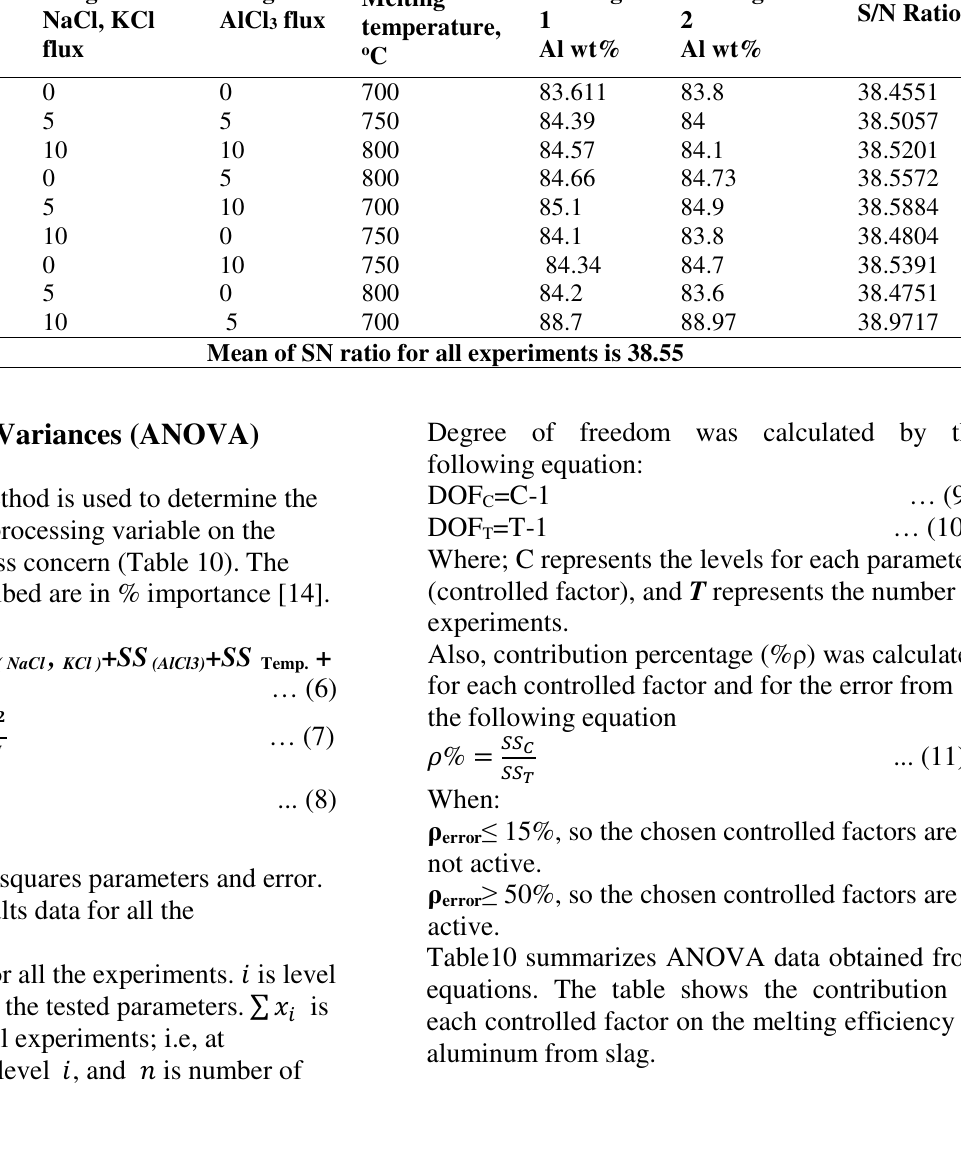
Values of S/N ratio for melting aluminum by using different fluxes and different temperatures. KAlF 4 flux Exp.